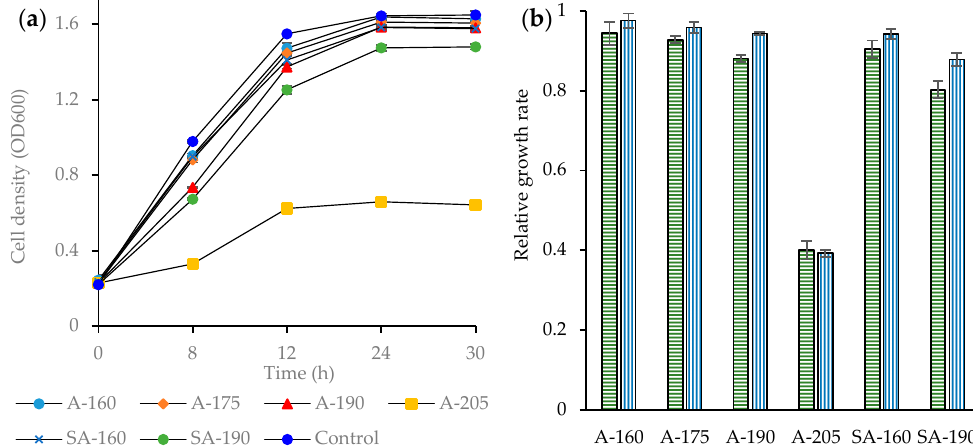
Figure 6. Cell growth of S. cerevisiae in the fermentation of the pretreatment liquids ( a ) and relative growth rate ( b ) after 12 h (horizontal green pattern bars) and 24 h (vertical blue pattern bars). Same codification of experimental conditions as in Table 1.